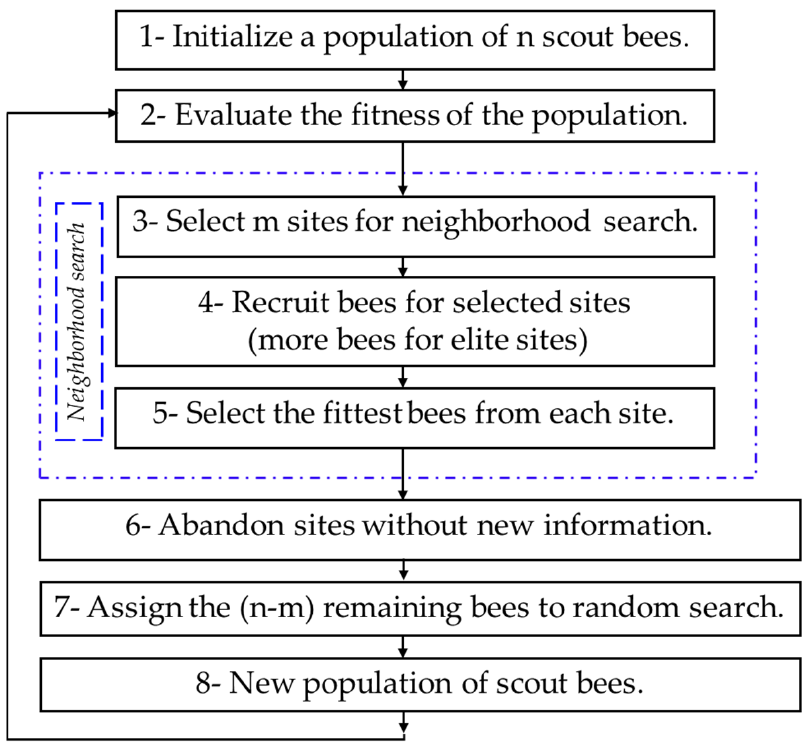
Figure 2. The Bees Algorithm flowchart.